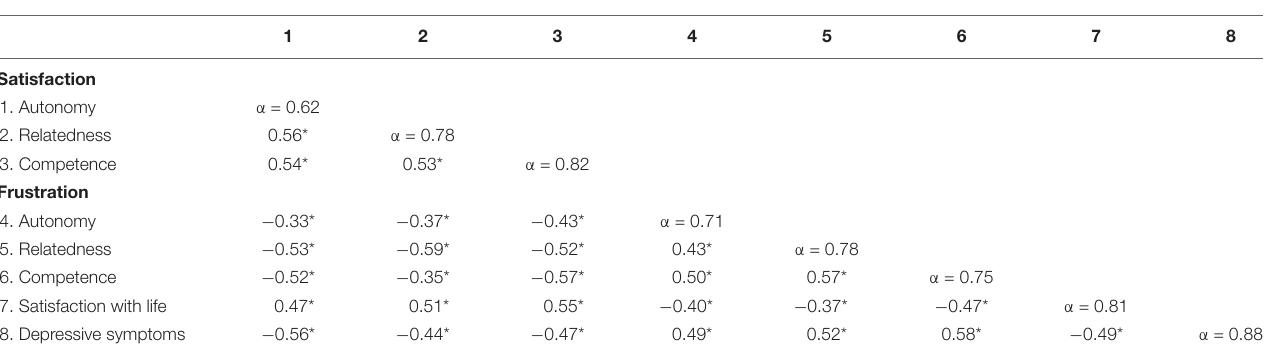
TABLE 4 | Correlations between basic psychological needs, satisfaction with life and depressive